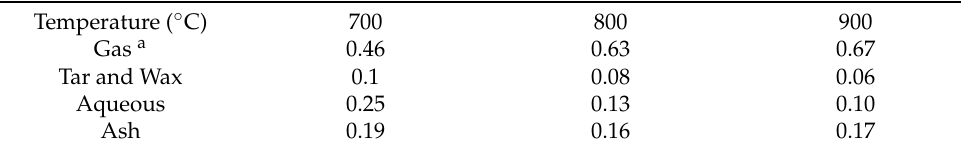
Table 2. Product mass yields of single-stage batch gasification of RDF [kg/kg RDF]. Temperature ( ◦ C)